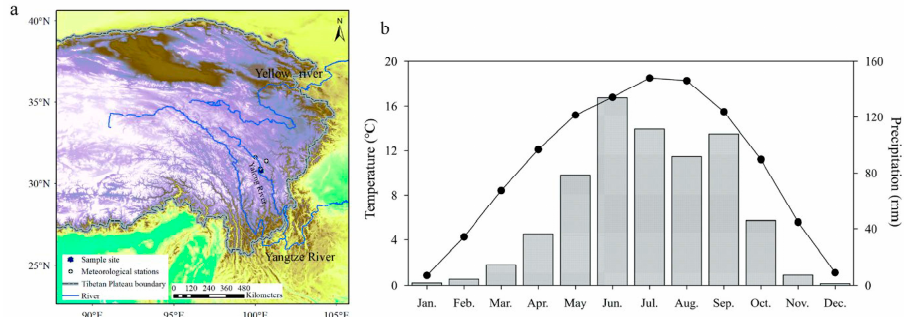
Figure 1. Locations of the sampling site, meteorological stations, ( a ) and monthly mean temperatures and total precipitation for the study area, which were calculated from 5 meteorological stations (Danba, Luhuo, Jinchuan, Xiaojin, and Daofu) during the period of 1962~2010 ( b ). Table 1. Statistical characteristics of the